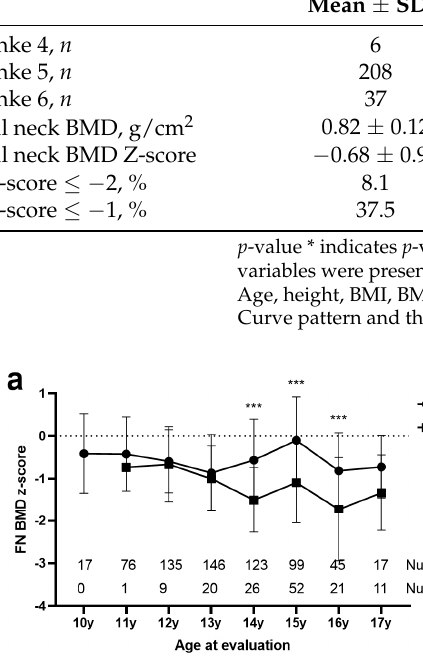
Figure 1. The mean value and standard error of femoral neck bone mineral density (BMD) ( a ) and proportion of low BMD ( b ) in AIS boys and girls. Subjects aged between 10–11 y were divided into the 10 y group,; the same criterion was used for other age groups; * indicates p < 0.05, ** indicates p < 0.01, *** indicates p < 0.001. Student’s t -test was used for ( a ), and the chi-squared test was used for ( b ). Table 1. Demographic data and information of bone mineral density in girl and boy AIS patients.